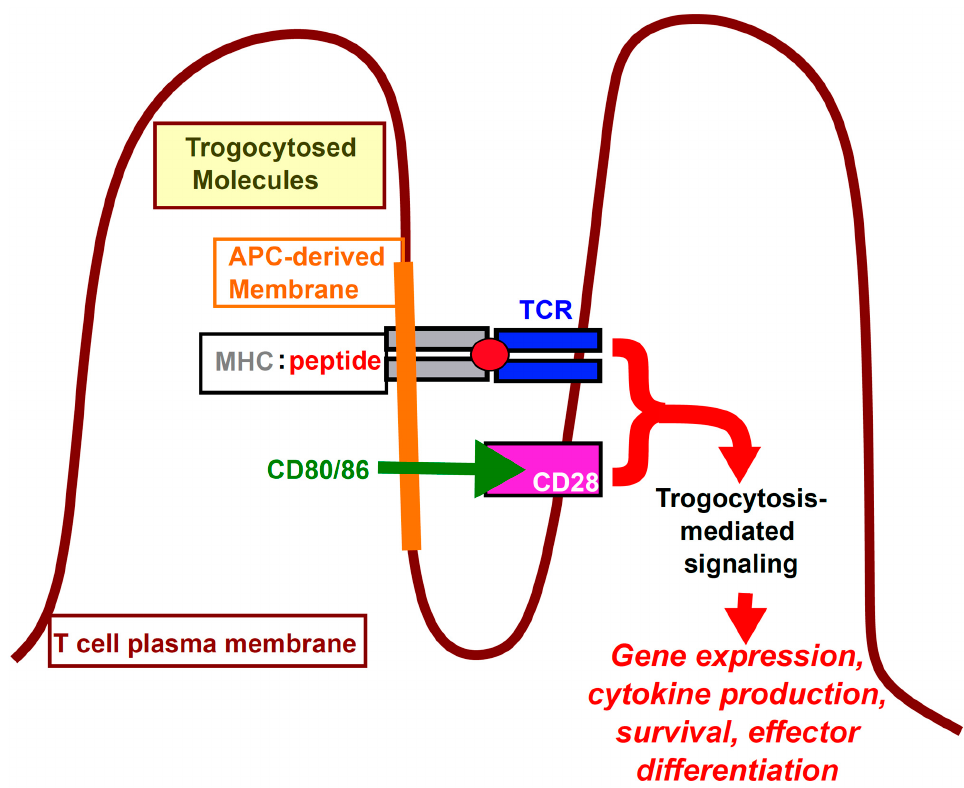
Figure 2. Simplified schematic of CD4 + T cell trogocytosis-mediated signaling. T cell membrane projections with APC-derived trogocytosed molecules (left) engage cognate receptors on the surface of the T cell (right) and induce TCR + co-stimulation signaling.